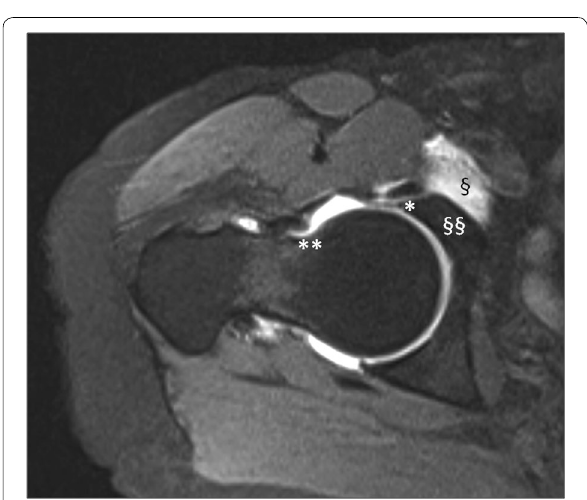
Fig. 4 Femur-based pincer FAI morphology. This arthro-MRI axial reconstruction performed with neutral rotation of the limb shows a retroverted neck of femur and some particular features of pincer FAI (*degenerated labrum; ** indentation line; § ilio-pectineal bursa dilated by contrast medium; §§ no signs of cartilage